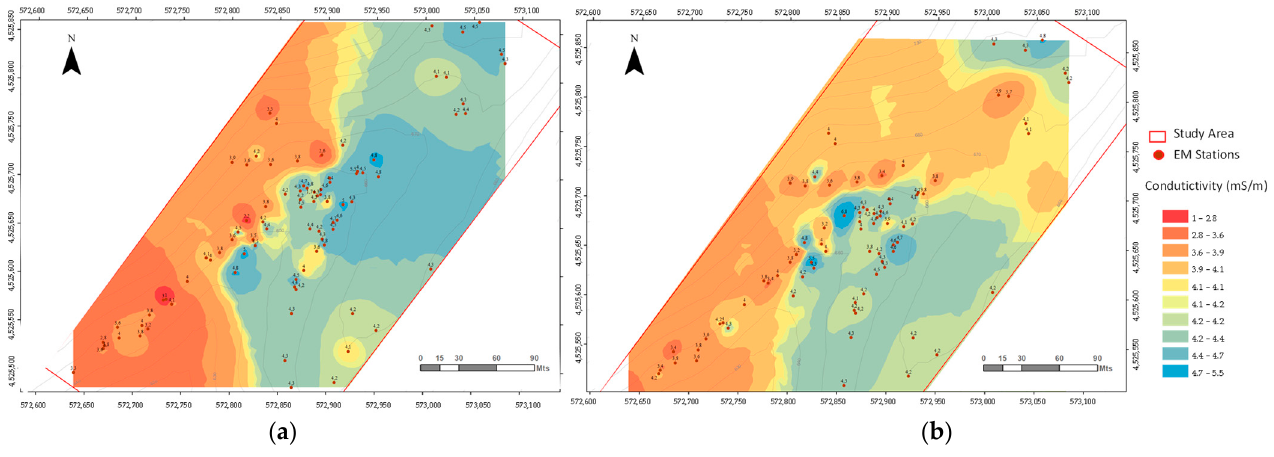
Figure 5. Relative electrical conductivity (EC) maps for: ( a ) Horizontal component dH (research depth to 3 m); ( b ) Vertical component dV (mS/m) (research depth up to 6 m).